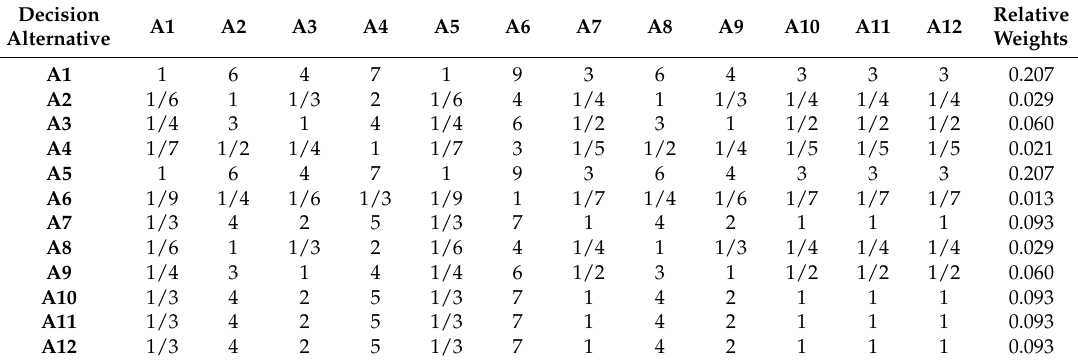
Table 6. Pairwise comparison matrix and relative weights of siting alternatives (A1–A12) with respect to EVC9